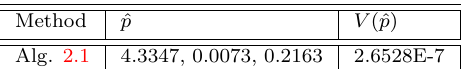
Table 11: Example 3.8. Results from step 2 in Alg.